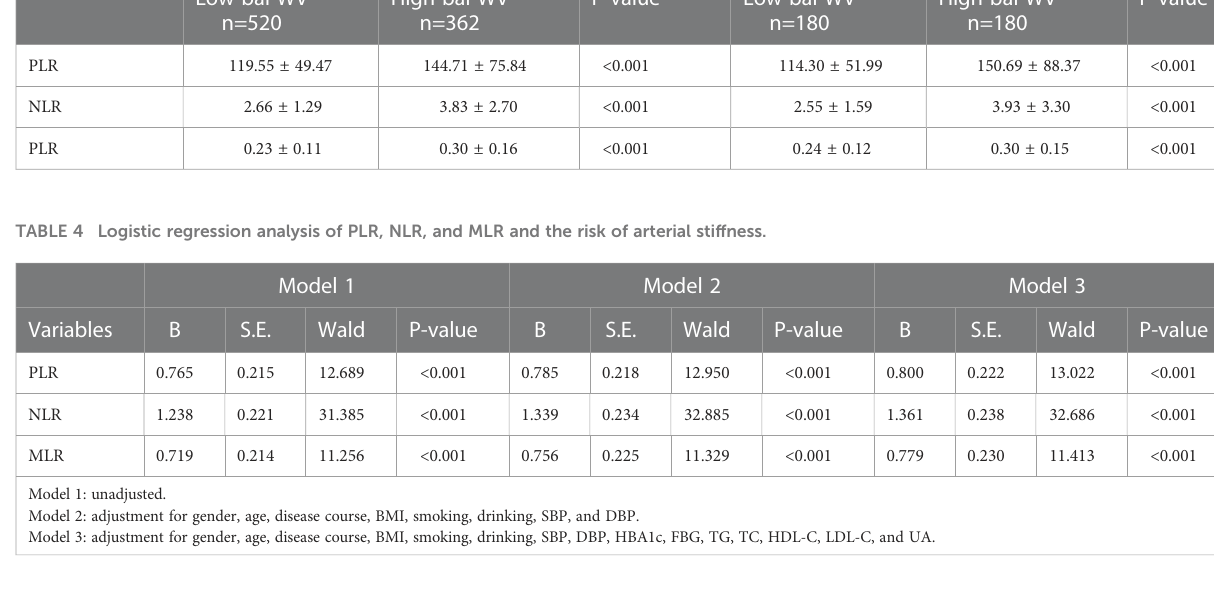
TABLE 3 Comparison of PLR, NLR, and MLR propensity scores before and after matching. Variables